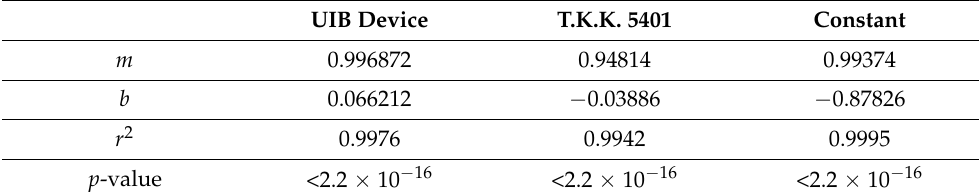
Table 2. Linear regression results ˆ y = mx + b . The linear model’s coefficients, r 2 value, and p -value for each device.